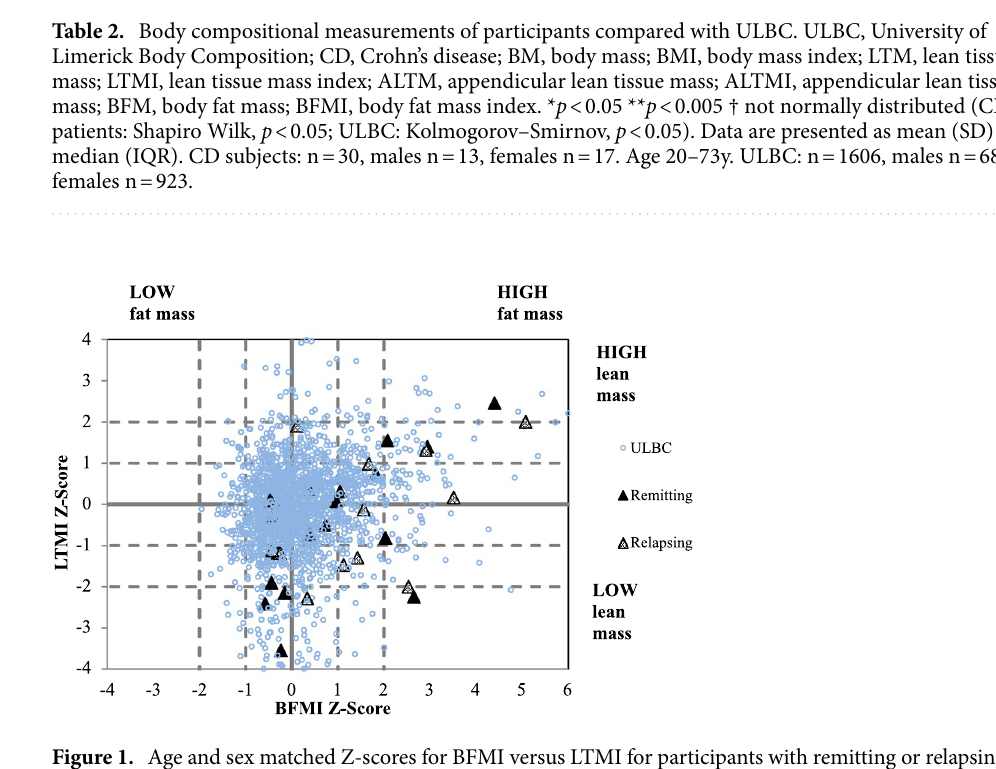
Figure 1. Age and sex matched Z-scores for BFMI versus LTMI for participants with remitting or relapsing CD and ULBC. LTMI, lean tissue mass index; BFMI, body fat mass index; ULBC, University of Limerick Body Composition Cohort. CD n = 30 (remitting n = 16, relapsing n = 14); age = 20-73y. ULBC (n = 1987); age =